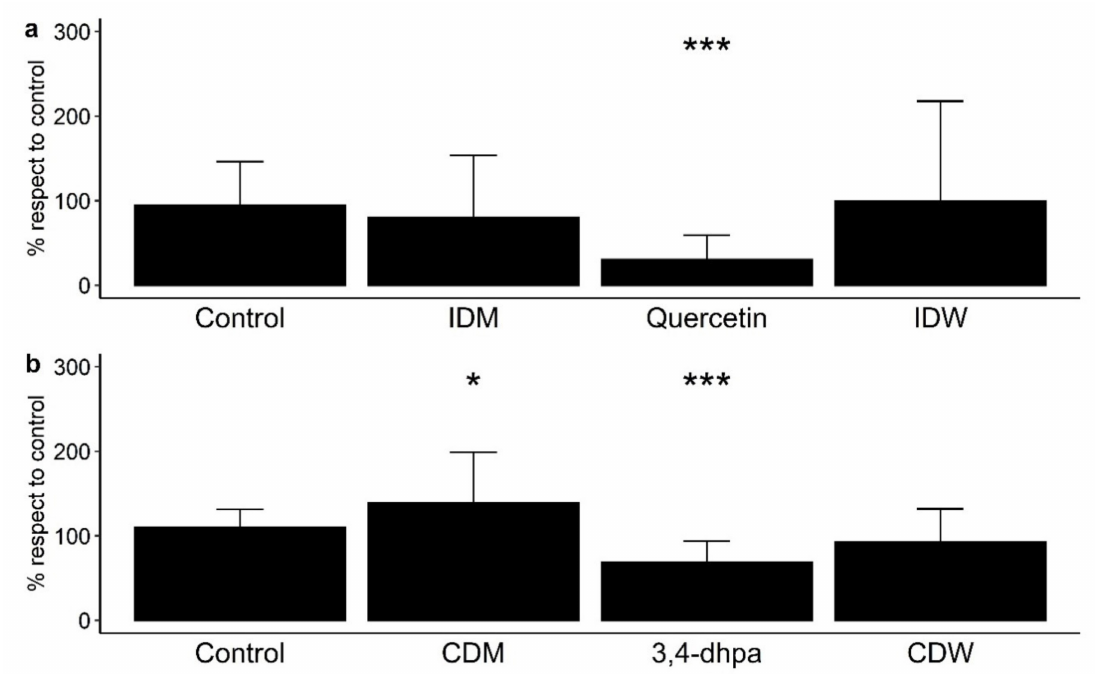
Figure 2. Effect on paracellular permeability in Caco-2 cells of ( a ) intestinal digestion medium (IDM), quercetin (200 µ M), and intestinal-digested wine (IDW) after 4 h of incubation, and ( b ) colon digestion medium (CDM), 3,4- dihydroxyphenylacetic acid (200 µ M) and colonic-digested wine (CDW) after 16 h of incubation. * significant differences to the control at p < 0.05, and *** p <